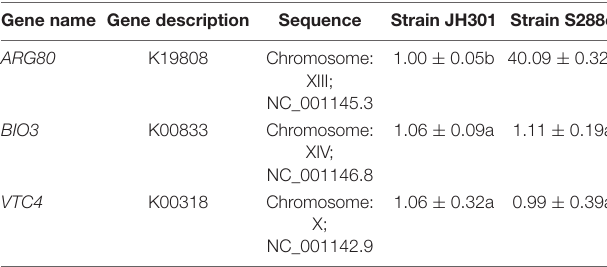
TABLE 5 | Quantitative real-time PCR analysis results.